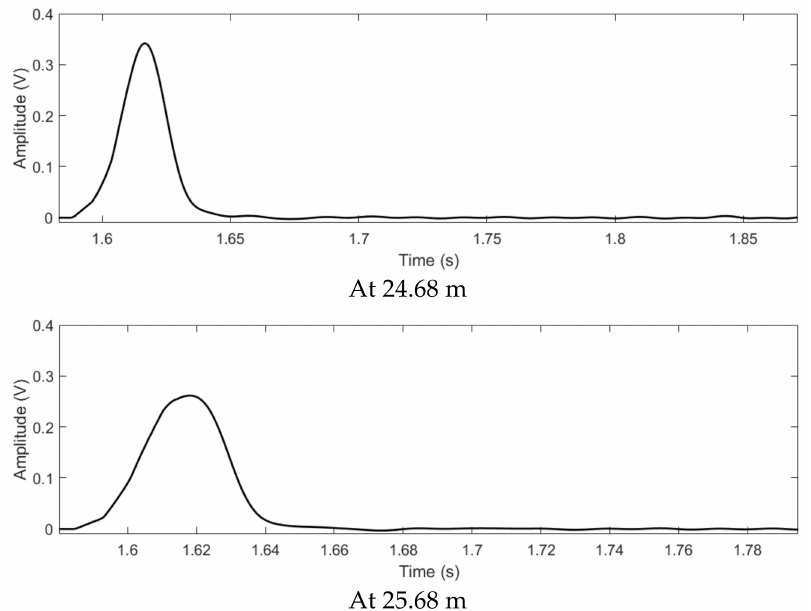
Figure 8. After the superposition, the L2’s signals of the TR localization method based on the maximum value.